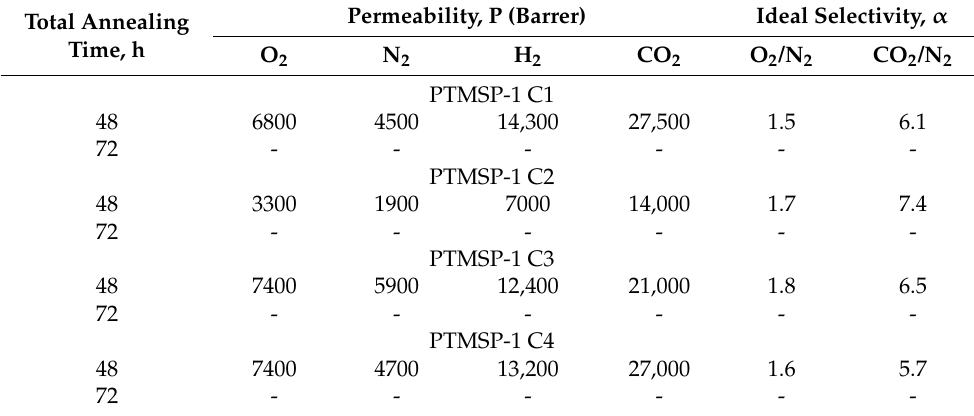
Table 3. The change in permeability coefficients of PTMSP-1 films containing stabilizers Irganox 1010 (C1), Vulkanox BKF (C2), Vulkanox BHT (C3), and Irganox 1076 (C4) during heat treatment (T = 140 ◦ C).